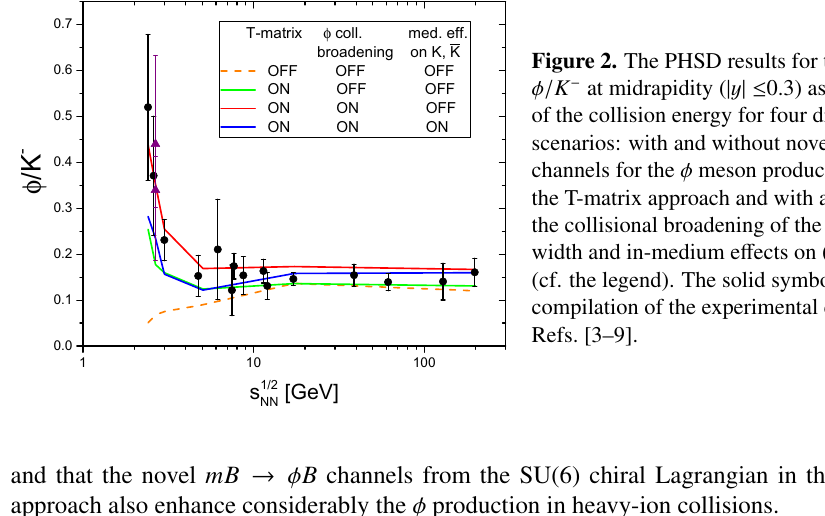
Figure 2. The PHSD results for the ratio φ/ K − at midrapidity ( y 0.3) as a function | | ≤ of the collision energy for four di ff erent scenarios: with and without novel mB channels for the φ meson production from the T-matrix approach and with and without the collisional broadening of the φ meson width and in-medium e ff ects on (anti-)kaons (cf. the legend). The solid symbols show the compilation of the experimental data from Refs.